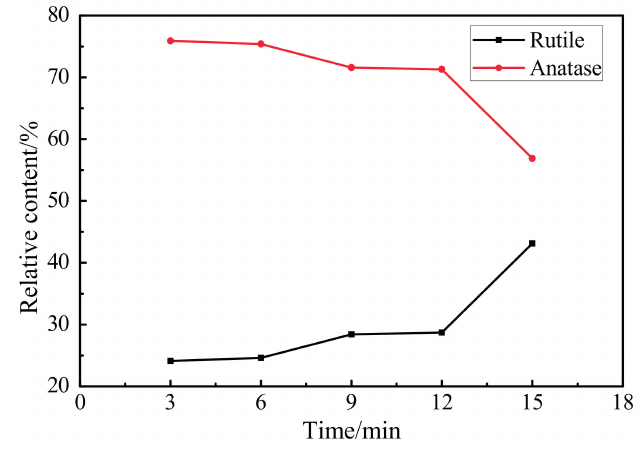
Figure 5. Relative contents (%) of rutile and anatase phases in MAO coating at different oxidation